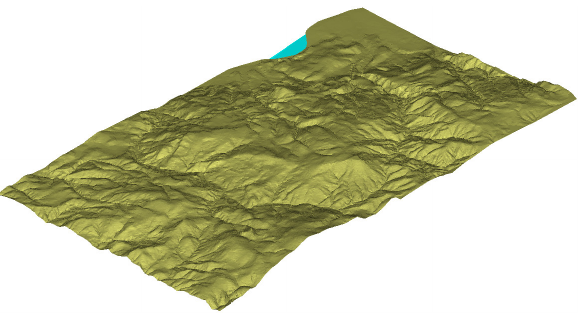
Figure 4: The archived local DEM over the test